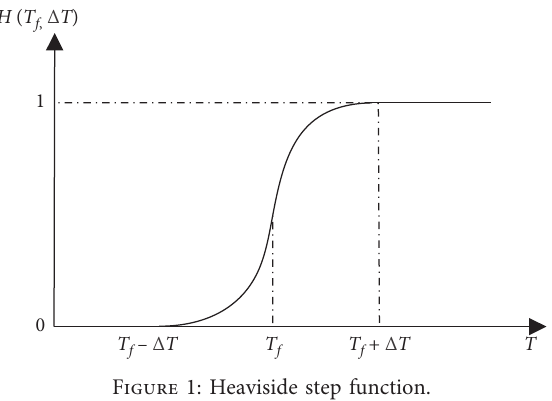
Figure 1: Heaviside step